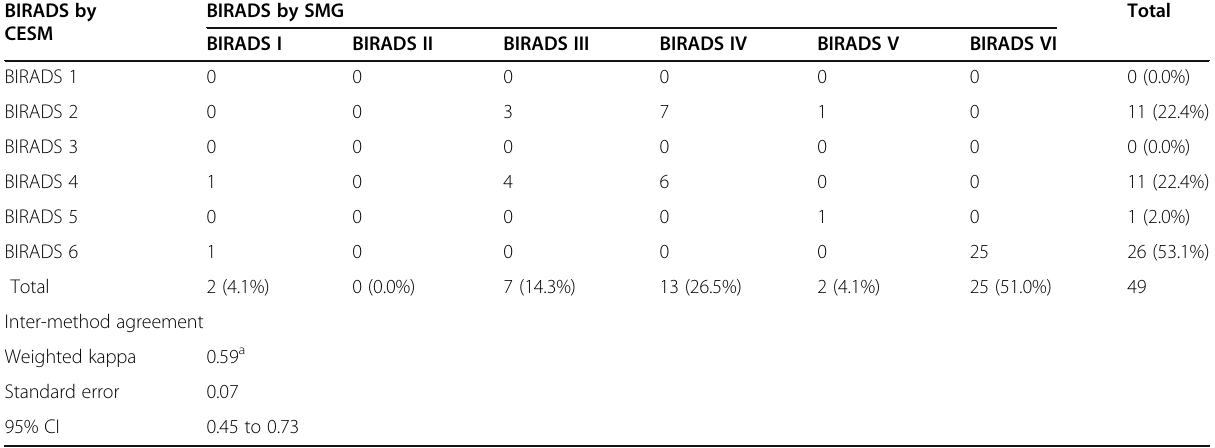
Table 11 Agreement between SMG and CESM as regards the BIRADS classification in patients with ACR grade A/B BIRADS by CESM